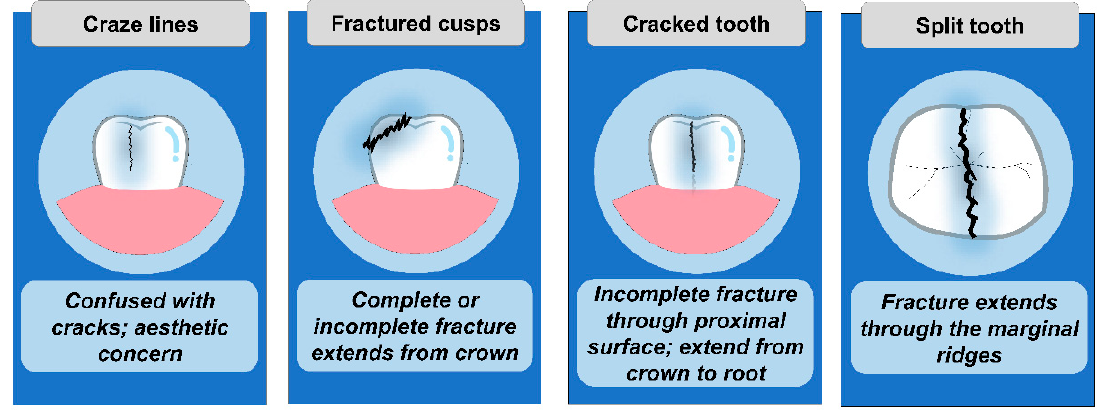
Figure 1. Type of tooth fractures.